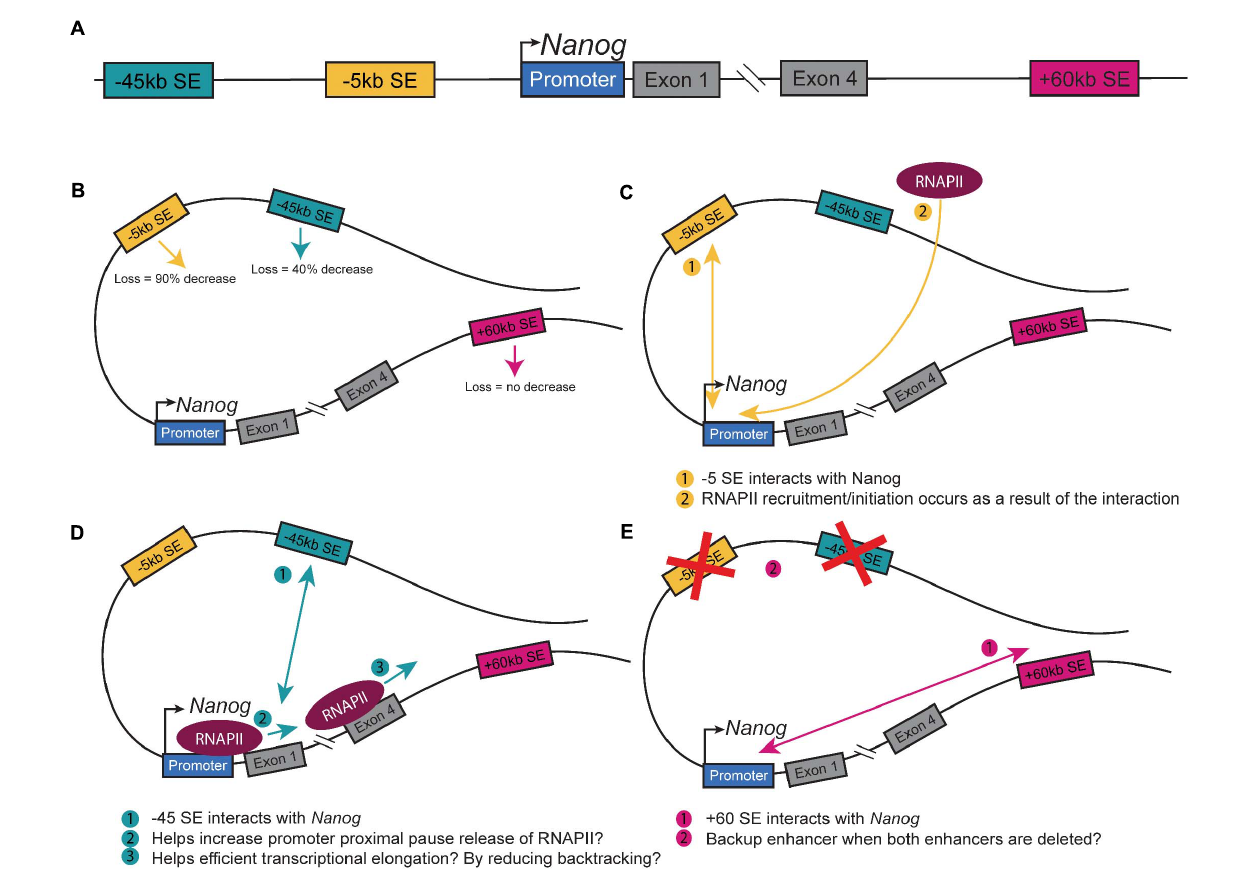
FIGURE 1 | Nanog Super-enhancers. (A) Schematic of the Nanog extended locus with the three SEs. Schematic of a theoretical loop containing all three SEs and Nanog depicting. (B) The changes in Nanog expression upon deletion (Blinka et al., 2016; Agrawal et al., 2021). (C) The interaction between the − 5SE and